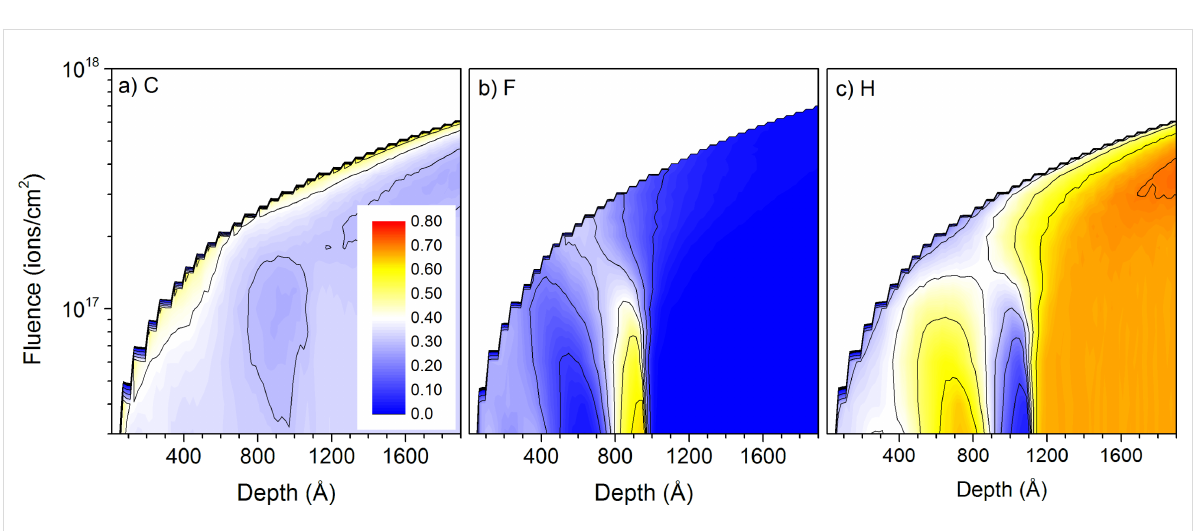
Figure 5: Sample composition as a function of depth and primary ion fluence for 20 keV Ar + irradiation of sample #4 with the thick-layer configuration: a) for carbon, b) for fluorine, and c) hydrogen. The colour scale shows concentrations from 0 to 80% and is identical for all species.